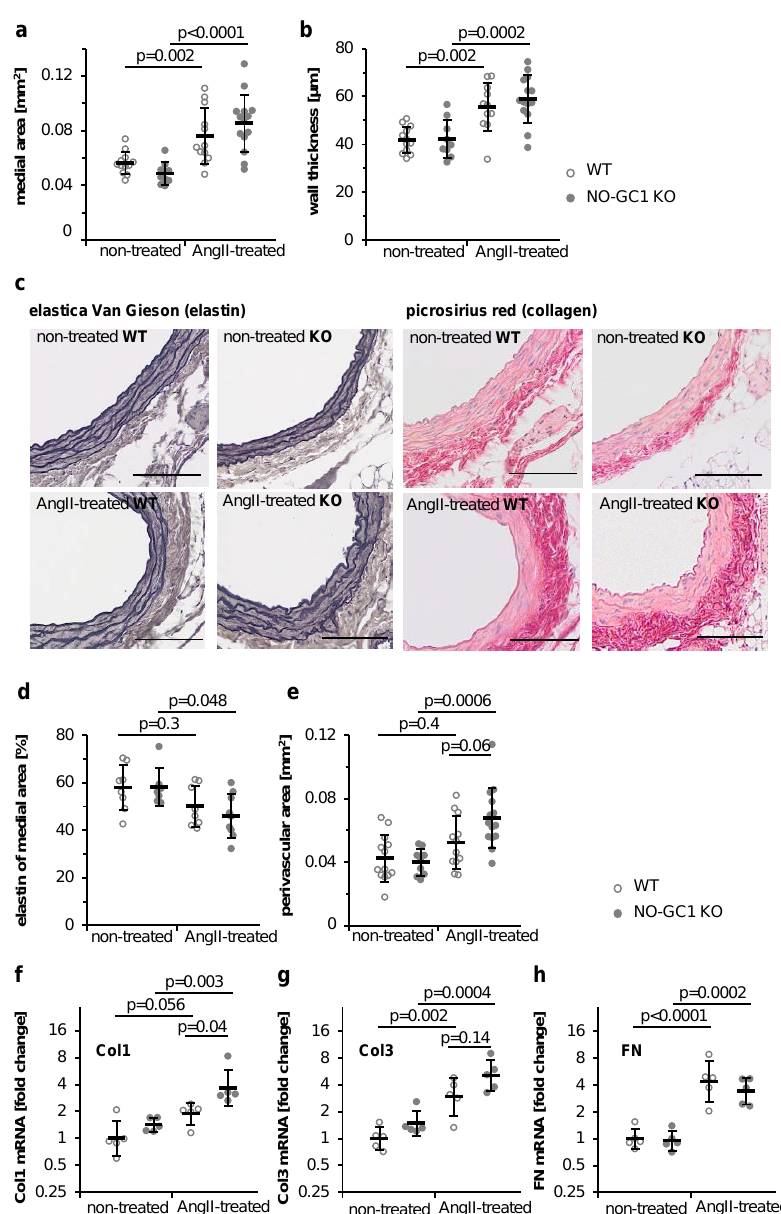
Figure 1. In NO-sensitive guanylyl cyclase (NO-GC)-1 KO mice, perivascular fibrosis and collagen1 mRNA content were increased by AngiotensinII (AngII) treatment. Medial area ( a ) and wall thickness ( b ) were measured in cross sections (5 µ m) of abdominal aortae from non-treated and AngII-treated WT and NO-GC1 KO mice. Shown are individual values (per animal) together with means ± SD. ( c ) Representative cross sections (5 µ m) of abdominal aortae from non-treated and AngII-treated WT and NO-GC1 KO mice stained with elastica Van Gieson (for elastin) and picrosirius red (for collagen). Scale bar, 100 µ m. ( d ) Elastin content is expressed as percentage of medial area of aortae from non-treated and AngII-treated WT and NO-GC1 KO mice. ( e ) Perivascular area of aortae from non-treated and AngII-treated WT and NO-GC1 KO mice were quantified. Shown are individual values (per animal) together with means ± SD. mRNA levels of ( f ) collagen1 ( g ) collagen3, and ( h ) fibronectin (FN) were determined using quantitative real-time PCR. ∆∆ Ct values to GAPDH and subsequently to non-treated WT were calculated and statistically analyzed. For graphical representation, 2 − ∆∆ C are shown in semi-logplots. Shownareindividualvalues(peranimal)togetherwithgeometricmeans ±